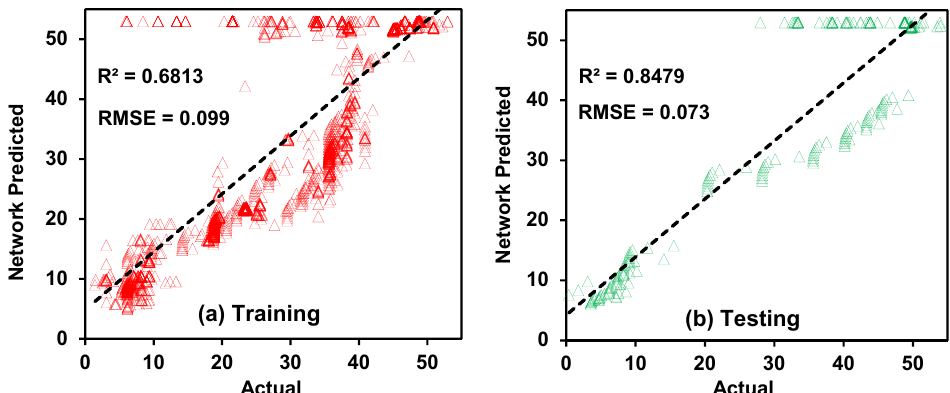
Figure 8. Linear activation function used to calculate the battery output data for the NN 1 model in ( a ) training and ( b ) testing.